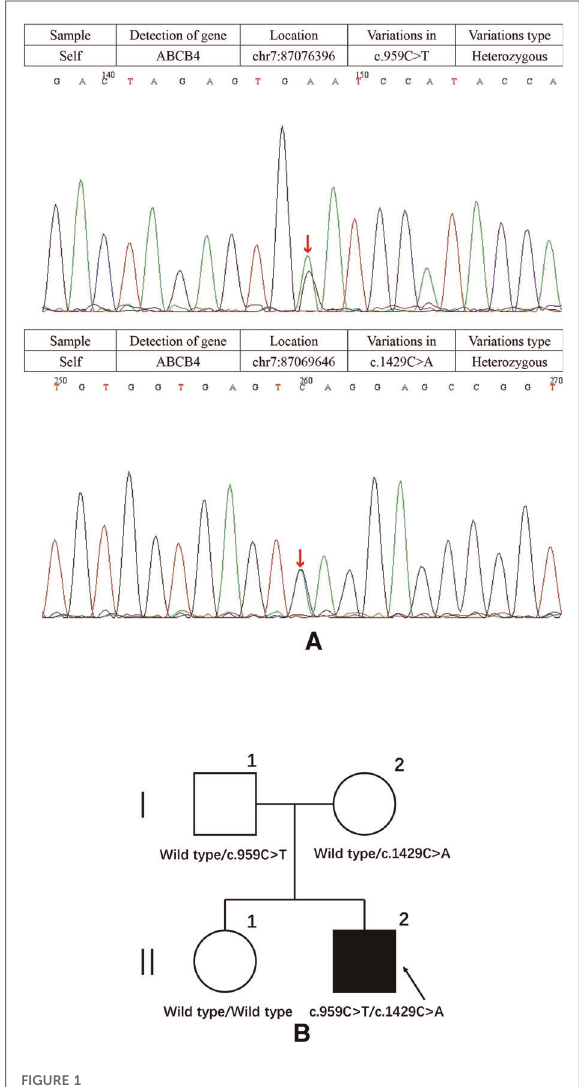
FIGURE 1 ( A ) results of the ABCB4 gene test. Gene mutation in c.959C>T and c.1429C>A (red arrows). c.1429C>A was observed due to the exchange of Glu to Lys in codon position 477, which is highly suspected to be a new genetic mutation. ( B ) Pedigrees showing affected proband, his sister and